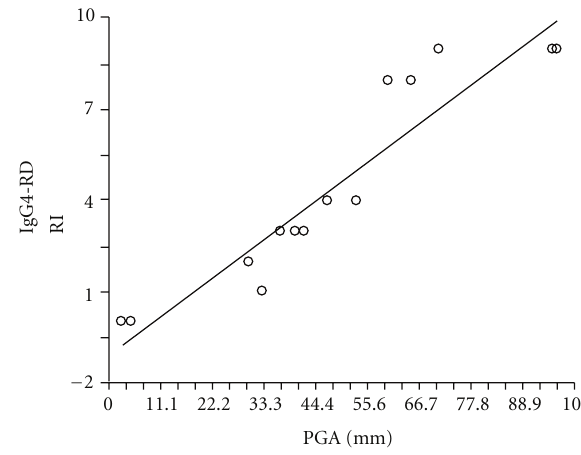
Figure 3: Correlation between physician global assessment (PGA) and IgG4-RD RI the PGA and IgG4-RD RI were compared using linear